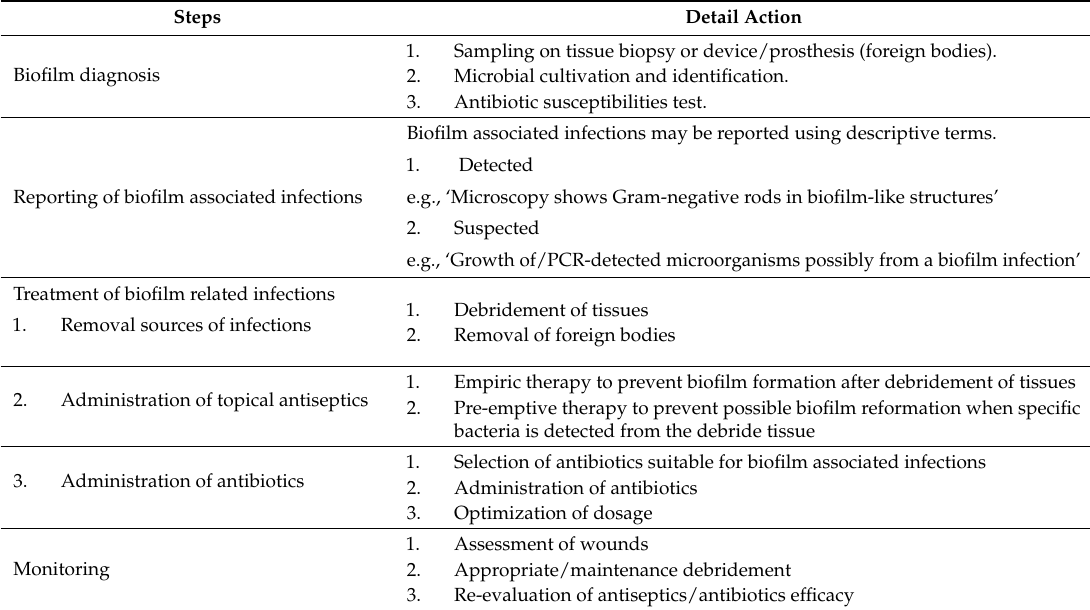
Table 2. Summary of guidelines for diagnosis and treatment of biofilm